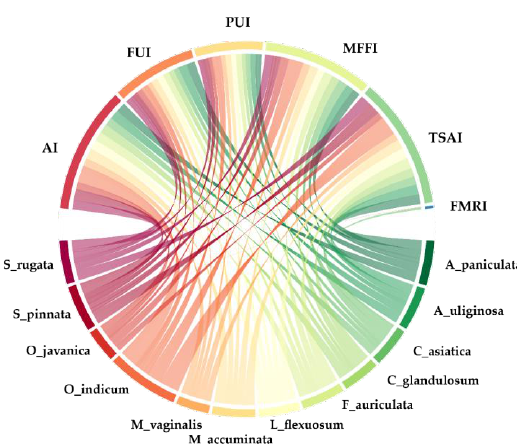
Figure 1. The relationship between twelve leafy vegetable species and the elements of CFSI in two Karen and two Lawa villages in northern Thailand. (AI = availability index; FUI = frequency of utilization index; PUI = plant parts used index; MFFI = multi-functional food use index; TSAI = taste score appreciation index; and FMRI = food-medicinal role index). The thicker the band, the more informants mentioned the relationship.